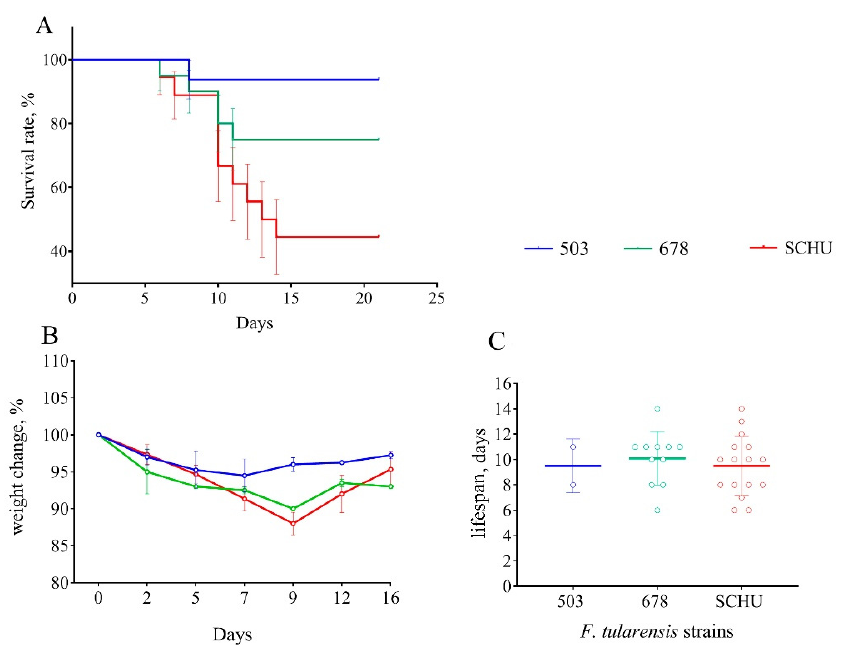
Figure 4. Survival rate ( A ), bodyweight changes ( B ), and lifespan ( C ) of mice immunized 120 days before infection with virulent strains of F. tularensis : subsp. holarctica 503, subsp. mediasiatica 678, and subsp. tularensis SCHU. Values are indicated with the standard error of the mean (SEM) for each measurement point.